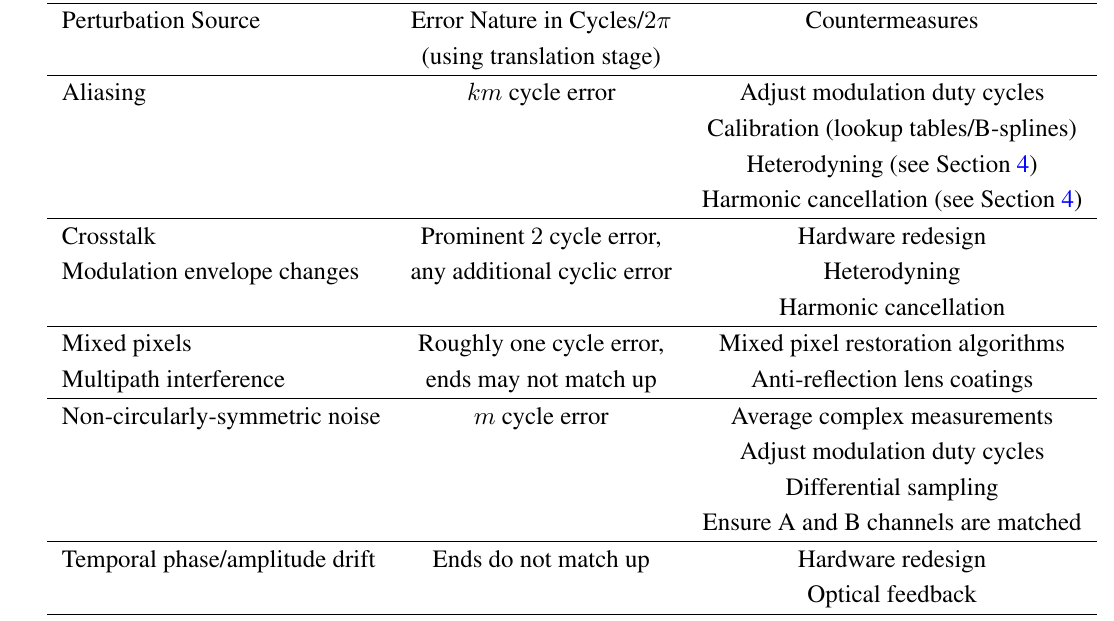
Table 1. Summary of error sources and corresponding mitigation